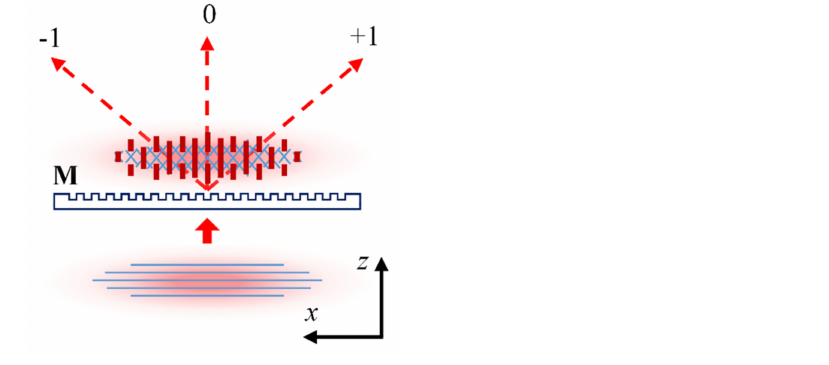
Figure 21. Multiple beam interference pattern produced near a first order phase